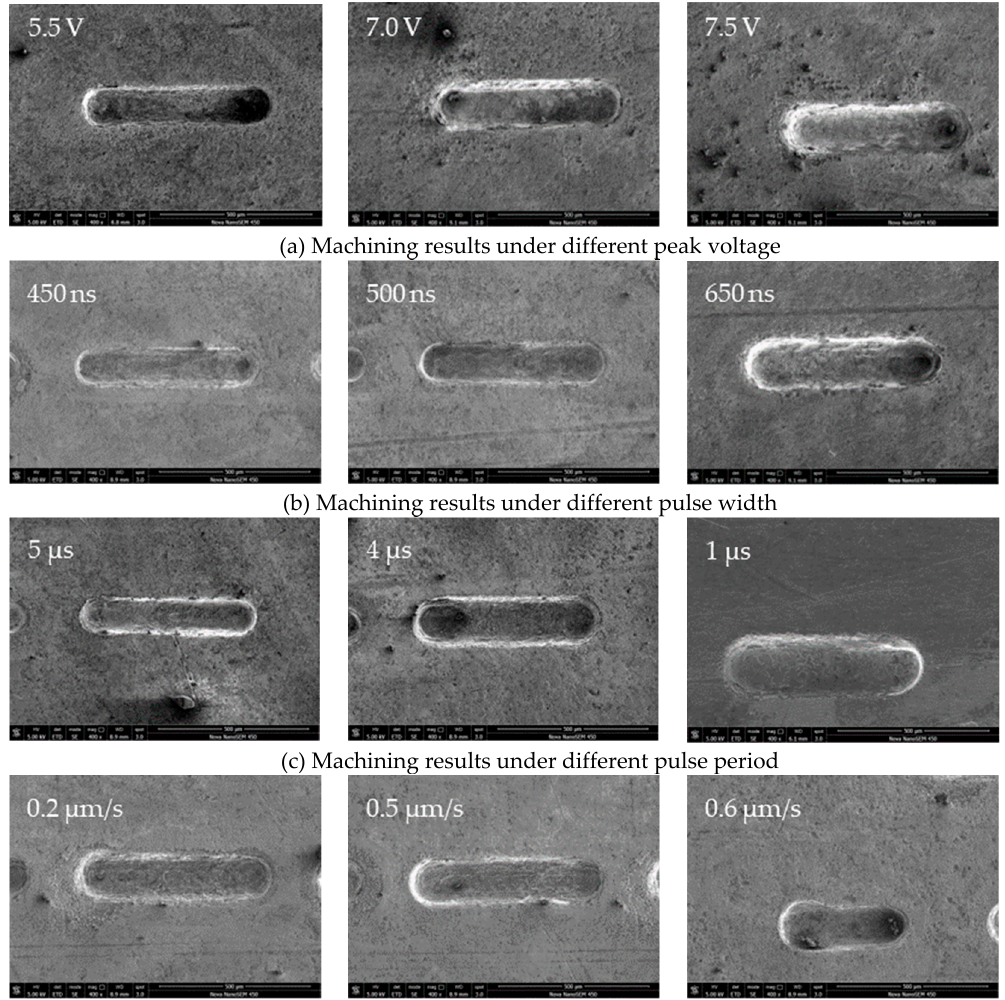
Figure 14. Machining results under different parameters.